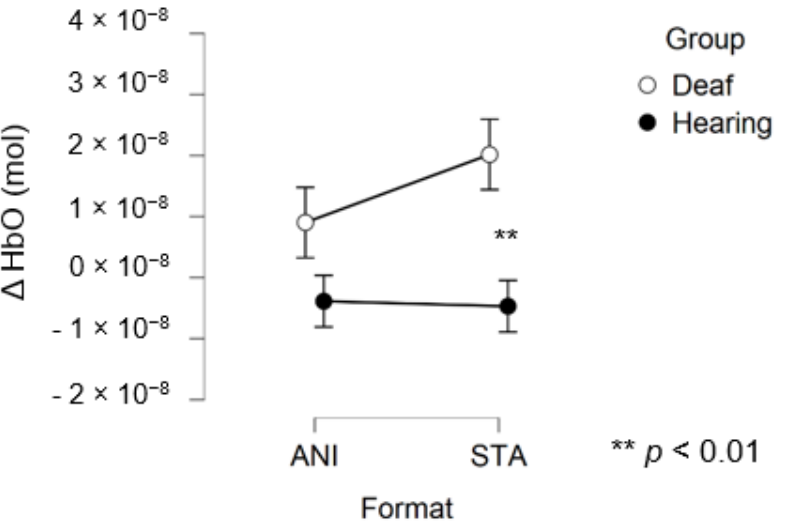
Figure 6. Mean amplitude values of the hemodynamic evoked responses in the frontal region for animated (ANI) and static image sequence (STA) formats for both groups.